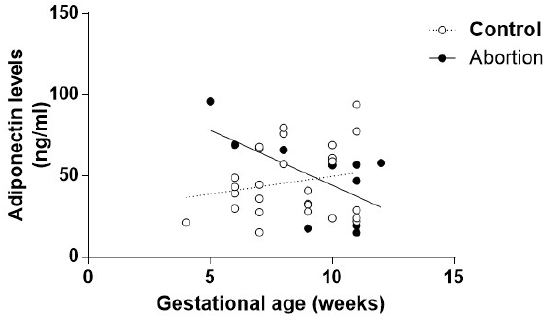
Figure A1. Normalization of adiponectin concentration to gestational age. Abortion slop is significantly non-zero. p = 0.04. The Pearson correlation coe ffi cient for the Abortion group is r = − 0.605 is statistically significant ( p =